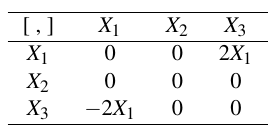
Table 2. Adjoint representation of